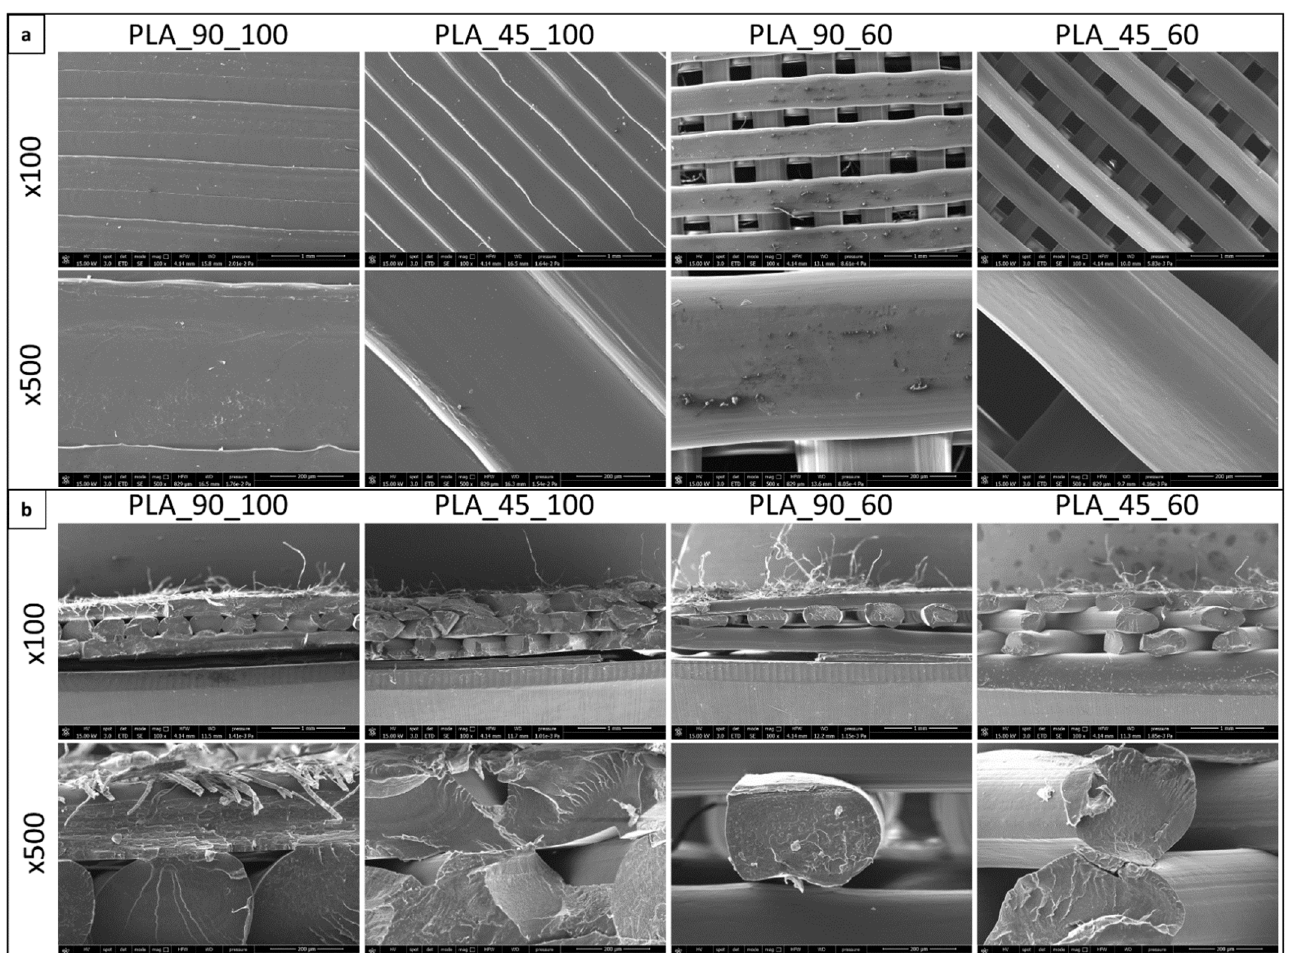
Figure 6. SEM analysis: ( a ) top-view and ( b ) cross-section of dog-bone-shaped PLA samples with different infill density and angle (magnification 100× and 500× in both cases).